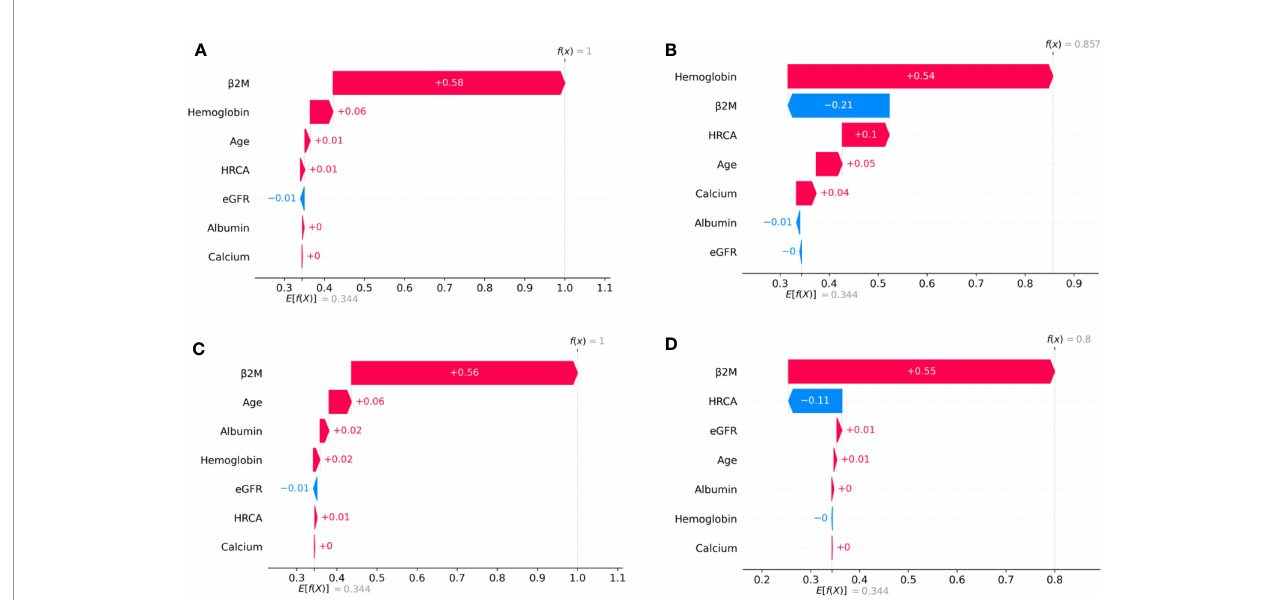
FIGURE 4 | SHAP waterfall plots for the randomly chosen four patients in low-risk stage (CRSS-1) from the MMIn dataset. The pink color shows the positive impact of the feature, while the blue color shows the negative impact of the feature. Features with a positive impact contributed to the class of low-risk stage prediction, while features with a negative impact contributed to class opposite to low risk. b 2M, hemoglobin, age, and HRCA have the highest overall impact on low-risk stage prediction in the MMIn dataset. However, this ranking itself differs from patient to patient as can be seen in (A – D) . (A) b 2M has the highest impact followed by hemoglobin, age, and HRCA. (B) Hemoglobin has the highest impact followed by b 2M and age. (C, D) b 2M has the highest impact followed by age and HRCA.